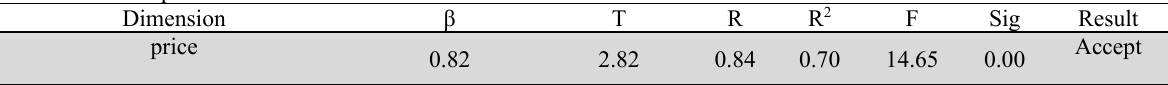
Results of test the price in the brand